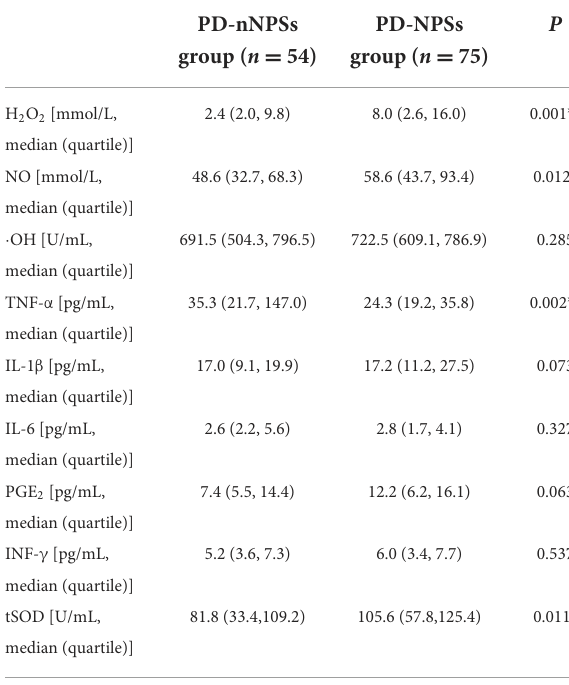
TABLE 2 Comparisons of demographic variables between PD-NPSs and PD-nNPSs groups.